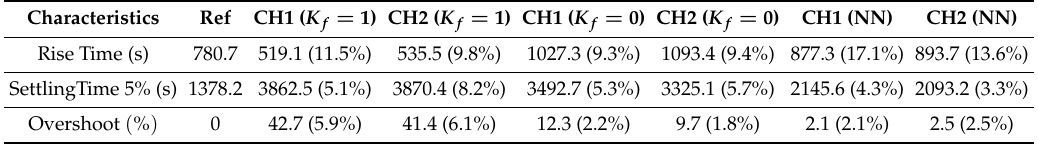
Table 4. Comparison of experimental results for time response characteristics (105 ◦ C to 100 ◦ C). Characteristics